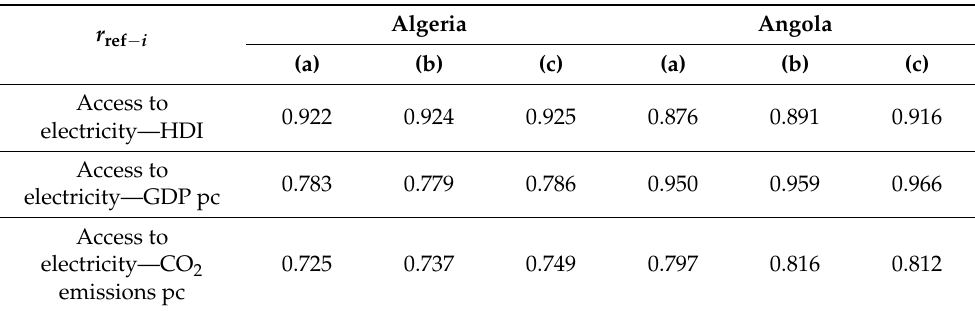
Table 9. Values of the relative degree of grey incidence r ref − i indices for two selected African countries. Source: own calculations.